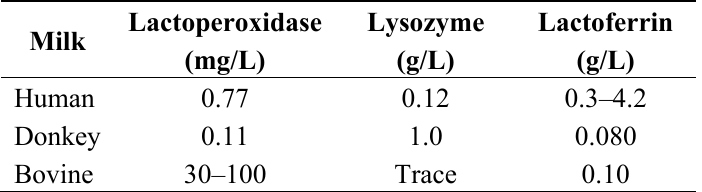
Table 4. Content of lactoperoxidase, lactoferrin and lysozyme from bovine, donkey and human milk  32 